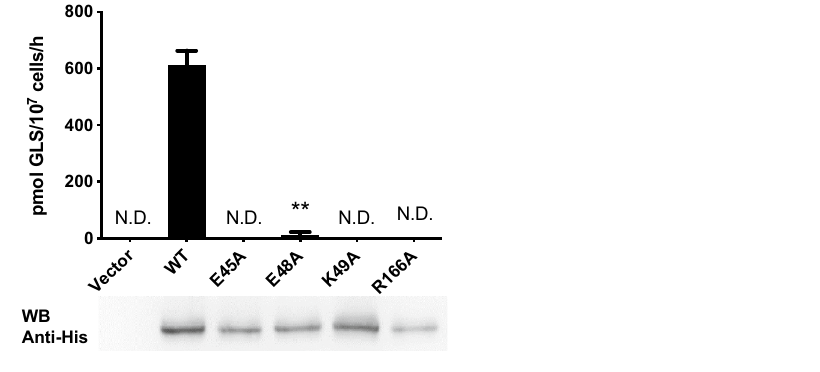
uptake assay. The reduced GLS uptake level was quantified by RP-HPLC and normalized to the control group. The dose–response curves were fitted by nonlinear regression, and the results showed that the GLS transport activity decreased exponentially as the concentration of these phytohormones increased (Fig. 4b–d). The 50% inhibitory concentration (IC 50 ) is 937.8 ± 113.85 μM for JA, 630.0 ± 47.51 μM for SA and 762.1 ± 48.14 μM for IAA (mean ± SEM, n = 3 for each concentration of competitors). Furthermore, both JA and SA showed a Hill slope near − 1 (JA: − 0.93 ± 0.120; SA: − 1.13 ± 0.100), whereas the Hill slope of IAA is − 1.66 ± 0.167, indicating IAA showed a positively cooperative inhibition. To elucidate the competitive properties of IAA, we measured the kinetic curves of AtGTR1 transporting GLS at IAA concentrations of 0, 250, 500, 1000 and 2000 μM (Fig. S5). The kinetic curves were fitted to Michaelis–Menten equation by nonlinear regression, and the V max and K m values are listed in Table S1. The V max values decreased with increasing IAA concentration, while the K m values were unaffected in presence of 250 and 500 μM IAA (Table S1). Only when the IAA concentration was higher than 1000 μM, the K m value increased slightly compared to the control group (Table S1). These results suggested a mixed type, non-competitive model of IAA inhibition on the GLS transport of AtGTR1. Together, these results suggested that JA, SA, and IAA are potential substrates or analogs of AtGTR1.